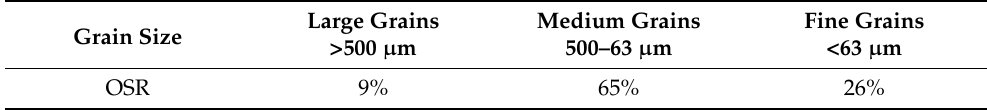
Table 16. Particle size distribution by sieves for OSR. Grain